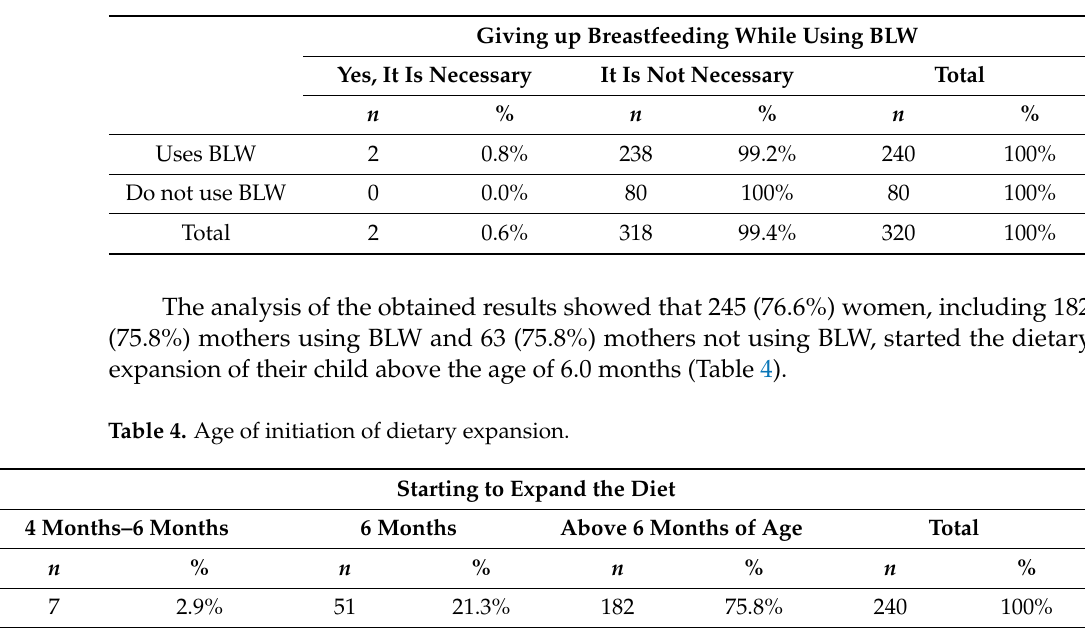
Table 3. Answers to the question “Should breastfeeding be abandoned while using the BLW method“—opinion among surveyed mothers.